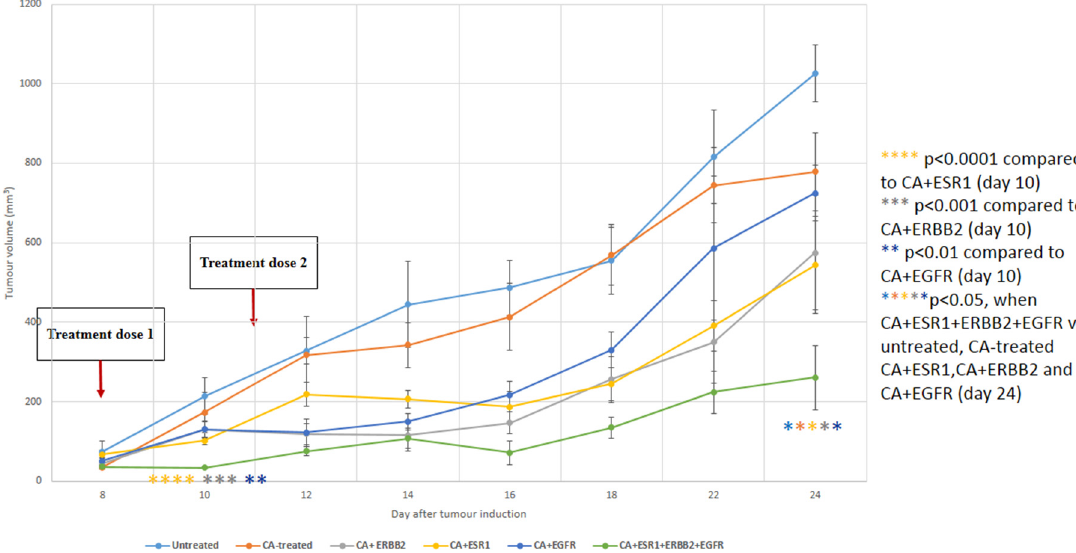
Figure 11. Tumor outgrowth volume of mice intravenously treated with CA+ERBB2 siRNA, CA+ESR1 siRNA, CA+EGFR siRNA and CA+ESR1+ERBB2+EGFR siRNAs complexes on a 4T1 induced breast tumor mouse model. Mice were administered twice (three days apart) with 100 μ L of CA, CA+ERBB2 siRNA, CA+ESR1 siRNA, CA+EGFR siRNA and CA+ESR1+ERBB2+EGFR siRNAs complexes. CA+siRNA complexes were formed by mixing 50 mM of a particular siRNA along with 4 μ L of 1 M CaCl 2 in 100 μ L of freshly prepared bicarbonated (44 mM) DMEM media and incubating at 37 °C for 30 min. Six mice per group were used and data was represented as mean ± SD. Values were significant with * p < 0.05 compare to the control group.